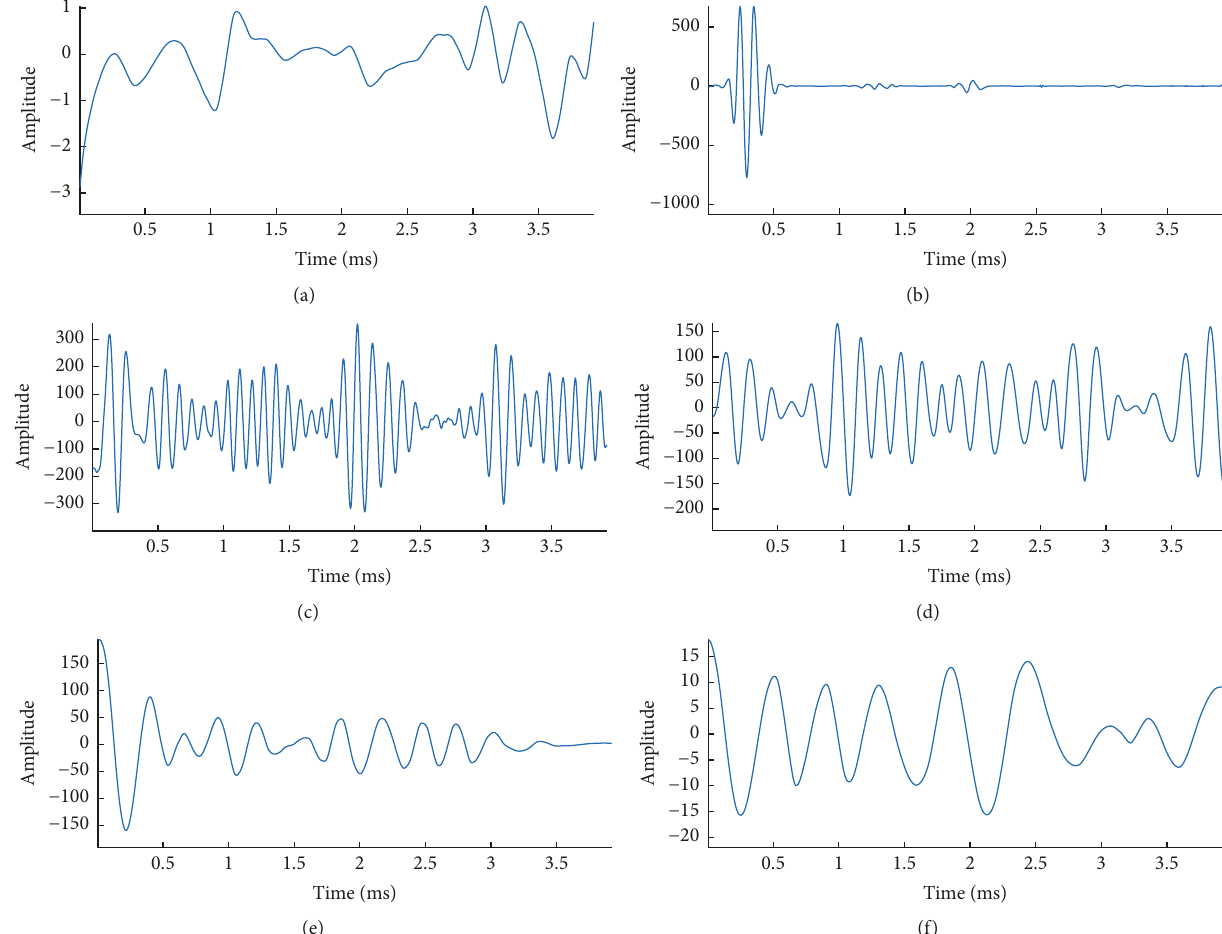
Figure 11: The IMF with the vibration signal after the decomposition with ICEEMD-De: (a) ∼ (f) show t IMF1 ∼ 6 which is the signal decomposed with ICEEMD-De.